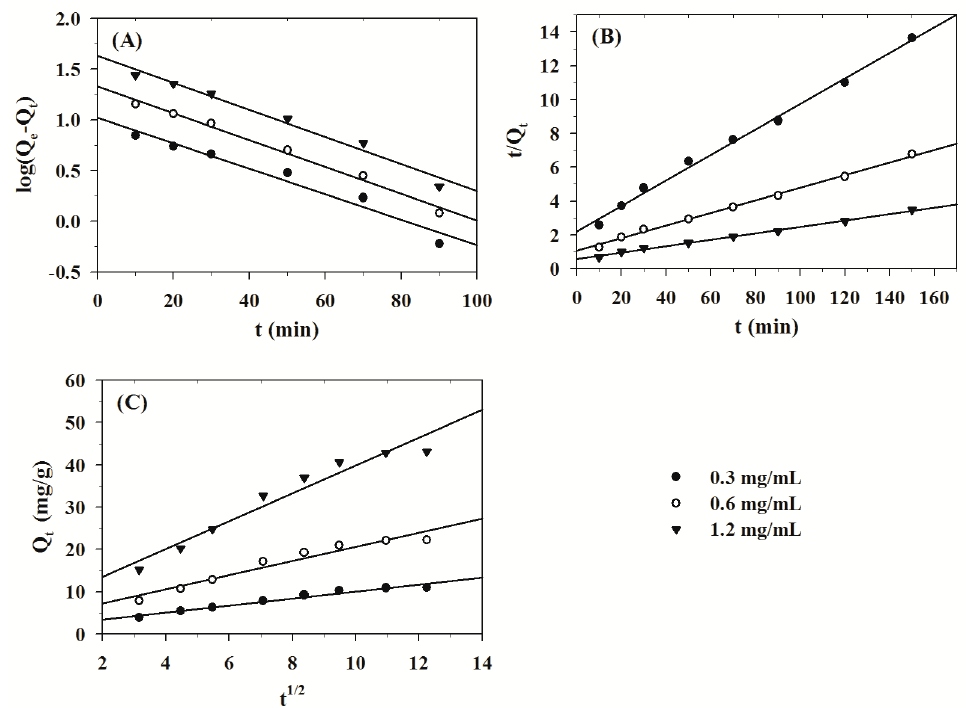
Figure 2. Pseudo first–order kinetic plot ( A ), pseudo second–order kinetic plot ( B ) and Weber and Morris intra–particle diffusion kinetic model ( C ) for the adsorption of TPS onto MPS (MPS dose = 1.0 g/50 mL, pH = 6.7, Initial conc. = 0.3–1.2 mg/mL, Temp. = 293 K).